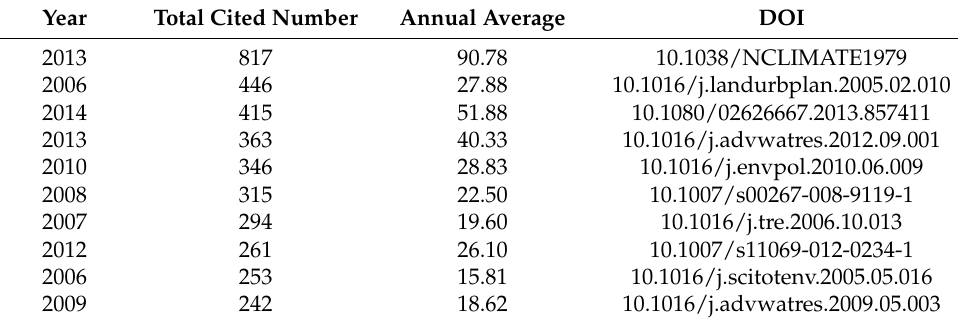
Table 1. Details of the top 10 highly cited